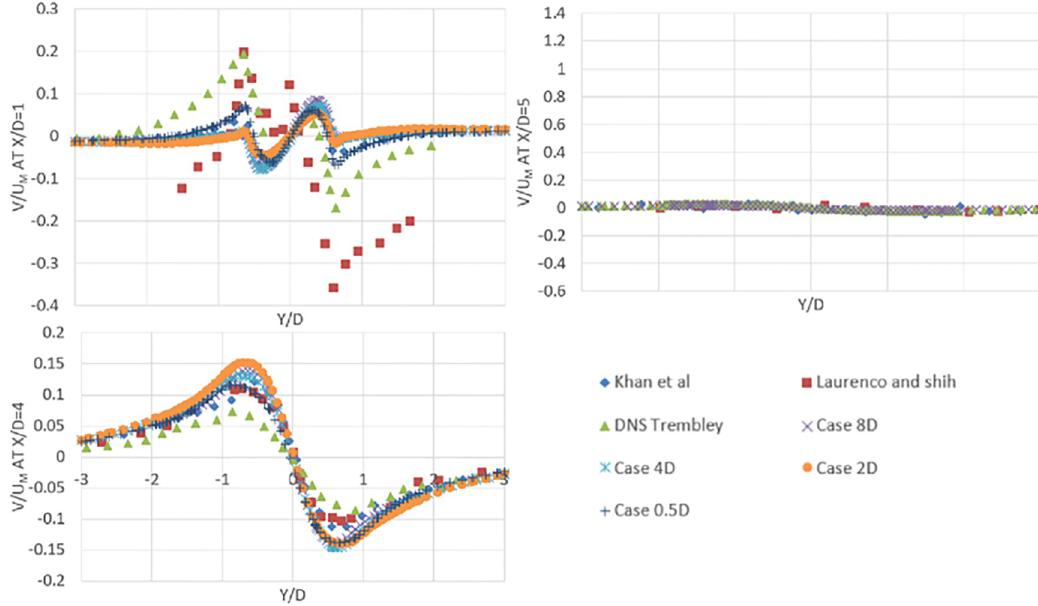
Fig 7. Comparison of mean crossflow velocity profiles of flow over cylinder at X/D = 1,3 and 5 for present study and other numerical and experimental results.